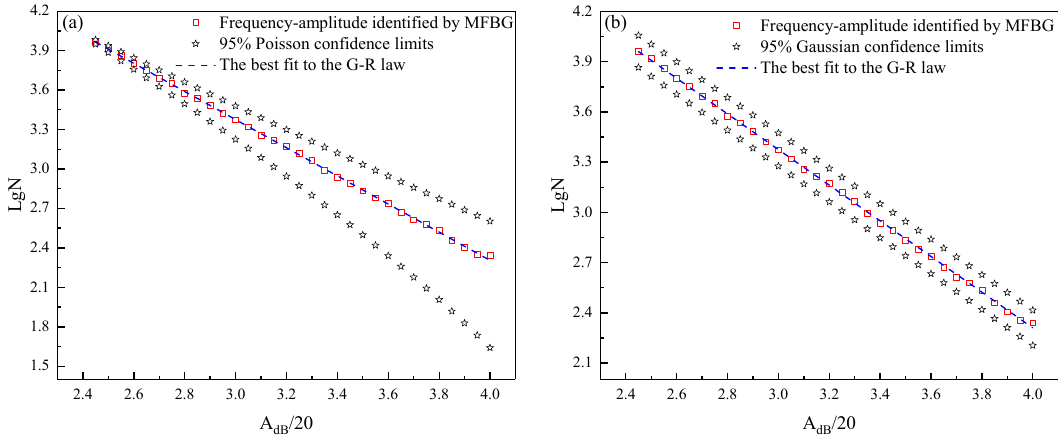
Figure 6. Ninety-five percent confidence limits of log-linear segment identified by MFBG from synthetic data with 100,000 data volumes. ( a ) GLM regression assuming Poisson error. ( b ) LSR regression assuming Gaussian error. Table 1. Estimated b values by MFBG when using GLM, LSR, and MLE regression.